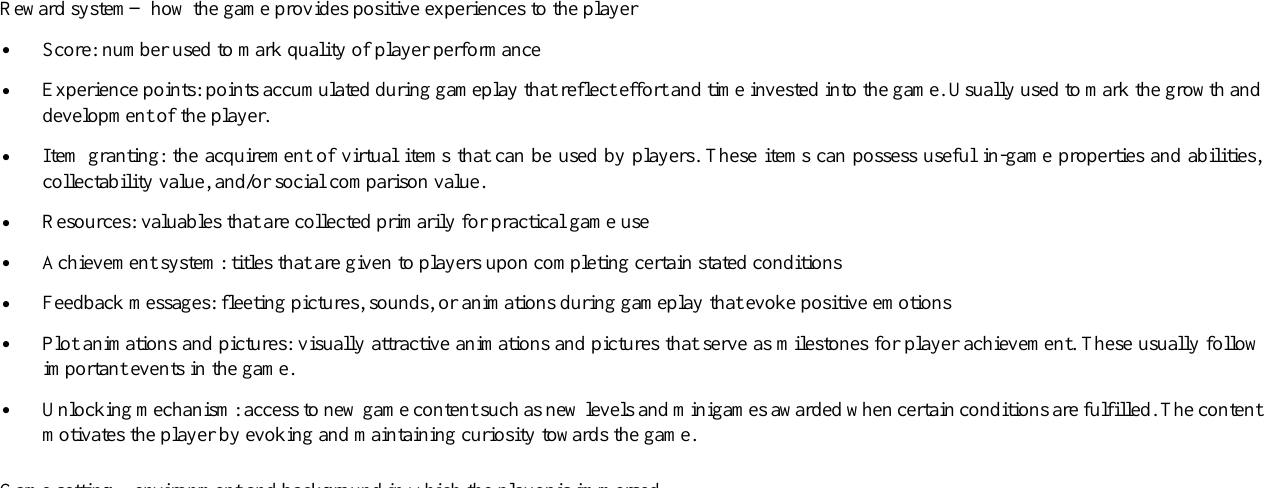
Textbox 1. Descriptions of the gameplay aspects obtained from survey respondents. Reward system—how the game provides positive experiences to the player